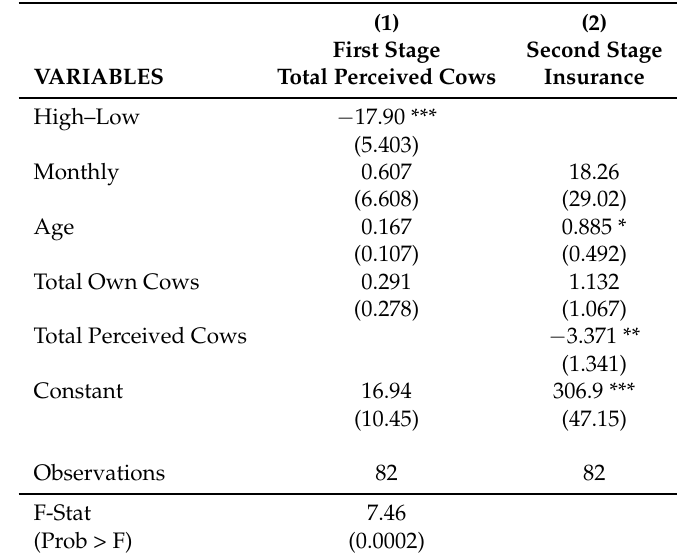
Table A3. First and Second Stage of Table 9, 2SLS, and the Effects of Perceived Farm Size on the Amount of Insurance Purchased in